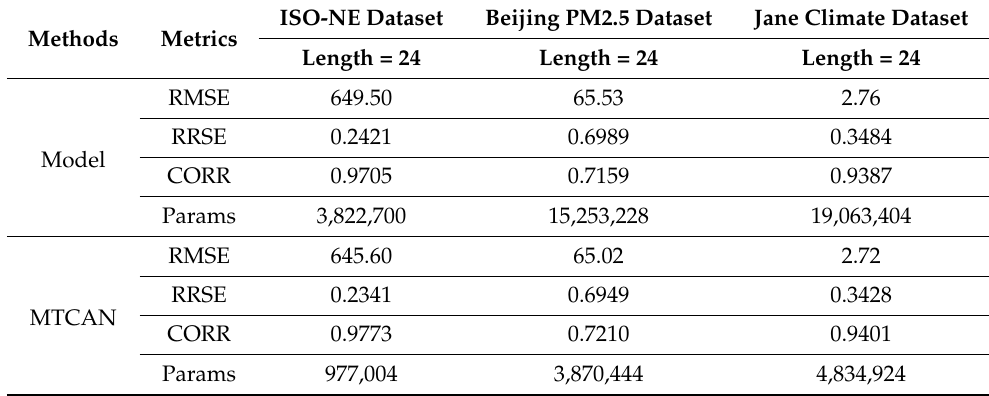
Table 3. Results summary (in RMSE, RSE, and CORR) of all methods with three datasets: each row has the results of a specific method in a particular